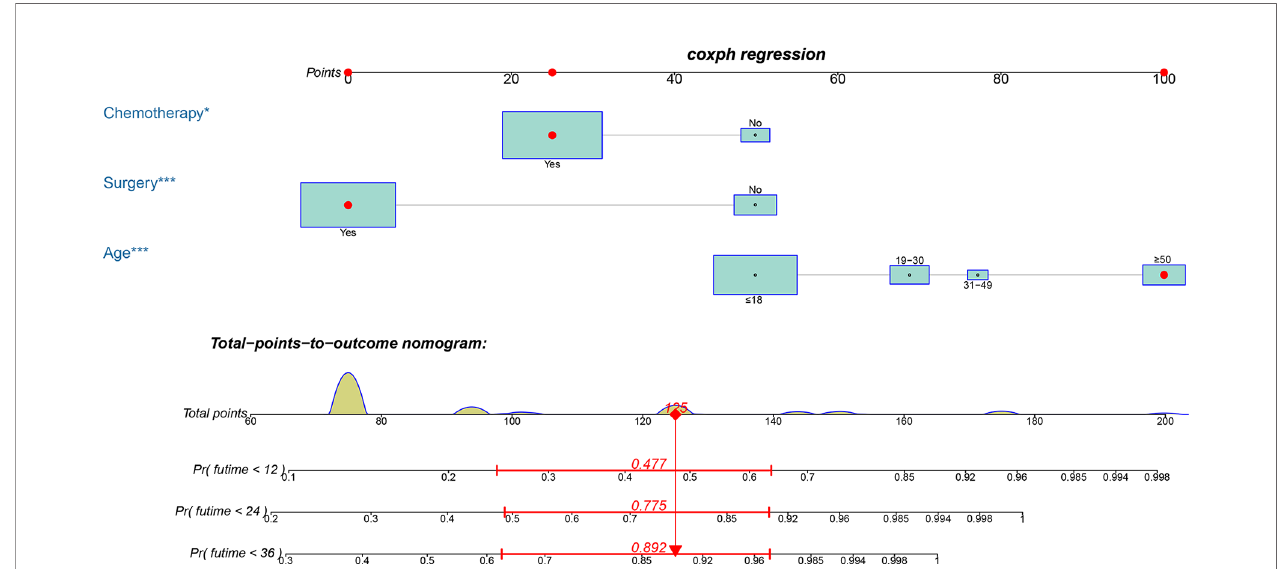
FIGURE 3 | A prognostic nomogram for predicting the OS of osteosarcoma patients with DM for the 12, 24, and 36 months.